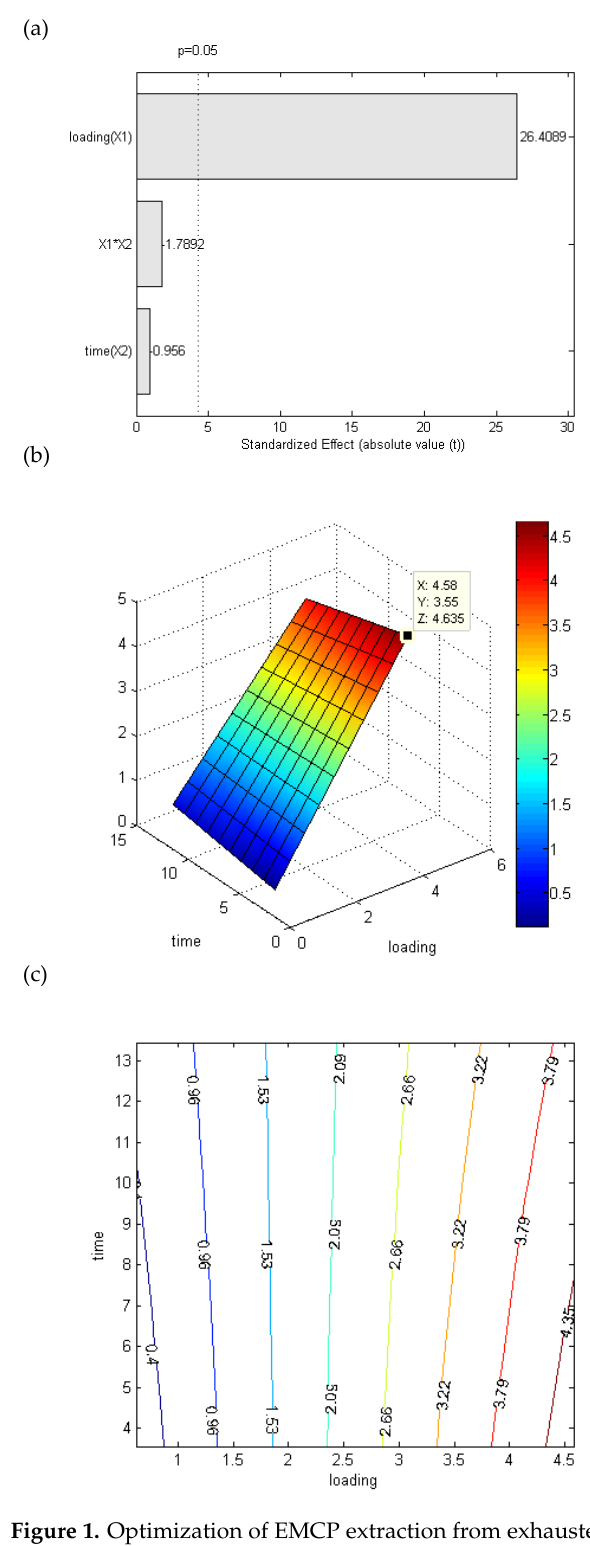
Figure 1. Optimization of EMCP extraction from exhausted Moradyn purple cob. ( a ) Pareto chart graphically describing the effect of each variable or their interaction on EMCP extraction yield. The vertical line indicated the significance of each effect ( p = 0.05). ( b ) Three-dimensional response surface plot (X = Ca 2+ loading, Y = time, and Z = yield) and ( c ) contour plot for the interactive effects of Ca 2+ loading (X1) and extraction time (X2) in EMCP extraction